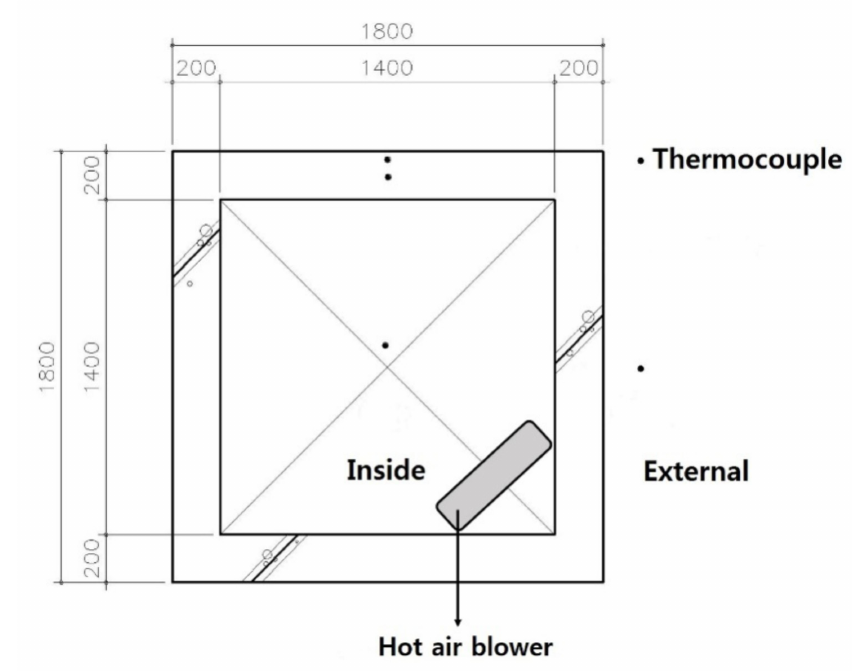
Figure 5. Thermocouple installation locations and placement of the hot-air